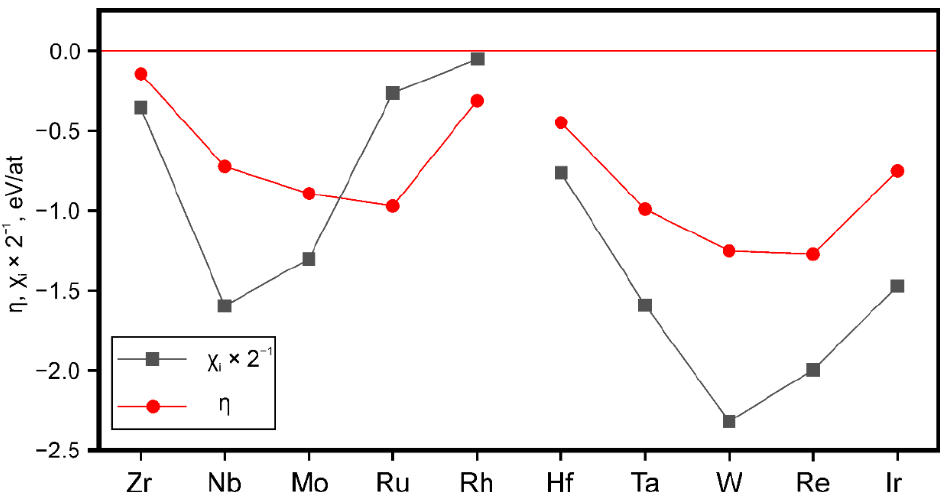
Figure 8. The χ i × 2 − 1 and η (eV/at.) parameters values when alloying nickel alloys with refractory transition metals [43]. (Reproduced with permission from Razumovskii IM [43]. Copyright (2020) Pleiades Publishing, Ltd.).